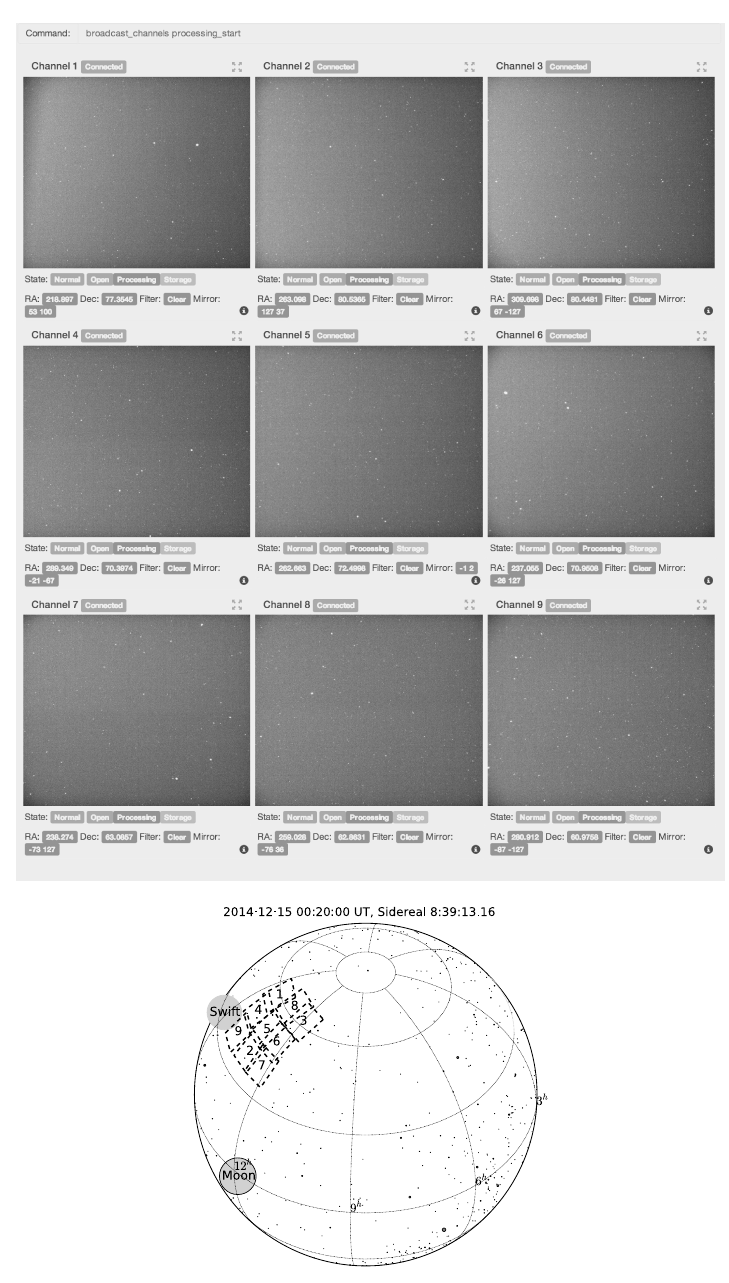
Fig. 4. Top panel: the sky view of all nine MMT channels as displayed by MMT control web interface. Bottom: actual placement of nine fields of view on the sky in the monitoring mode. The actual positions of the Moon and the Swift gamma-ray observatory viewfield are marked by the gray